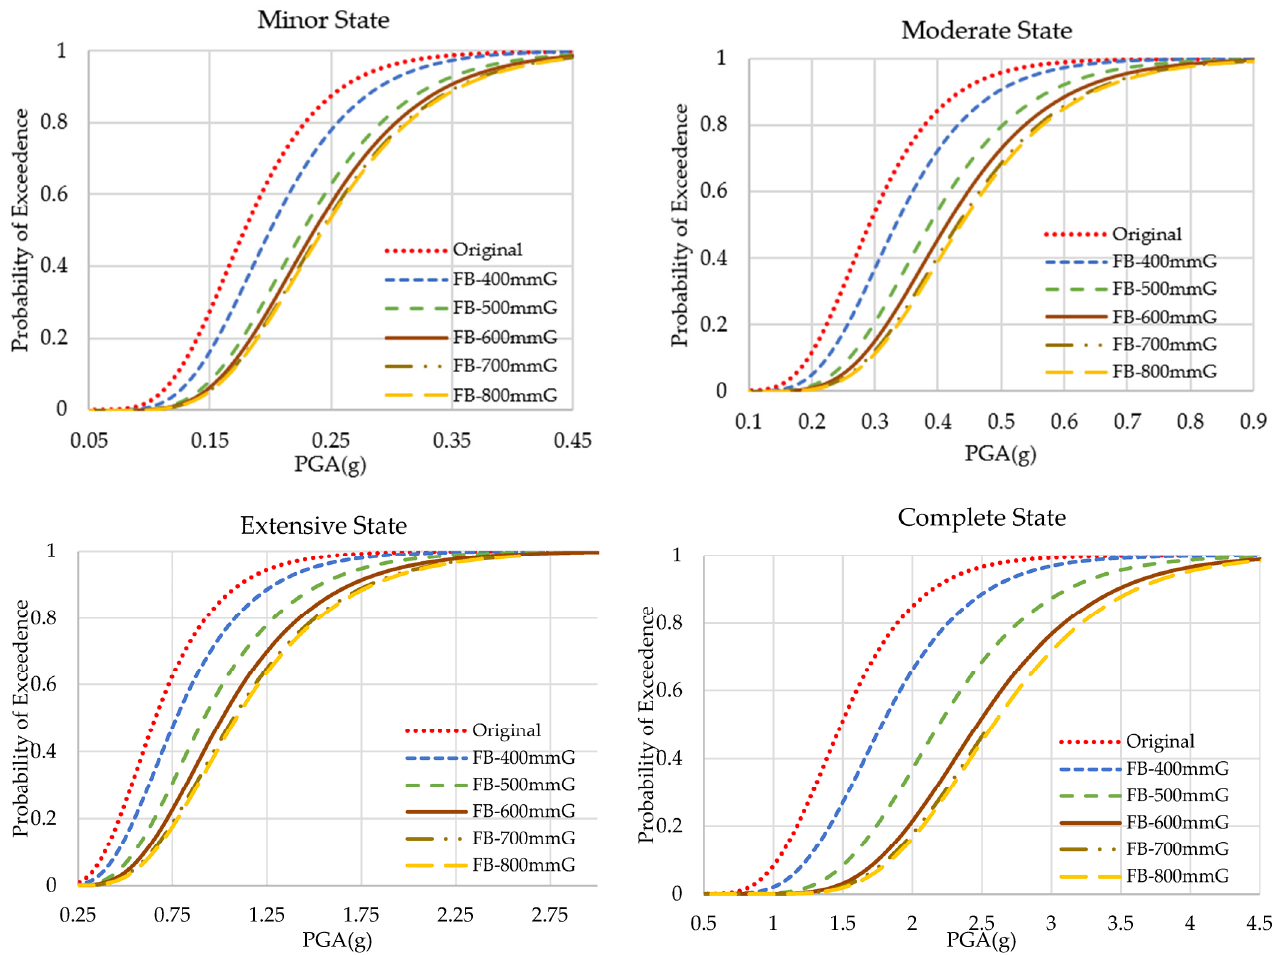
Figure 11. Fragility curves of the original and GFRP flange ‐ bonding frames.